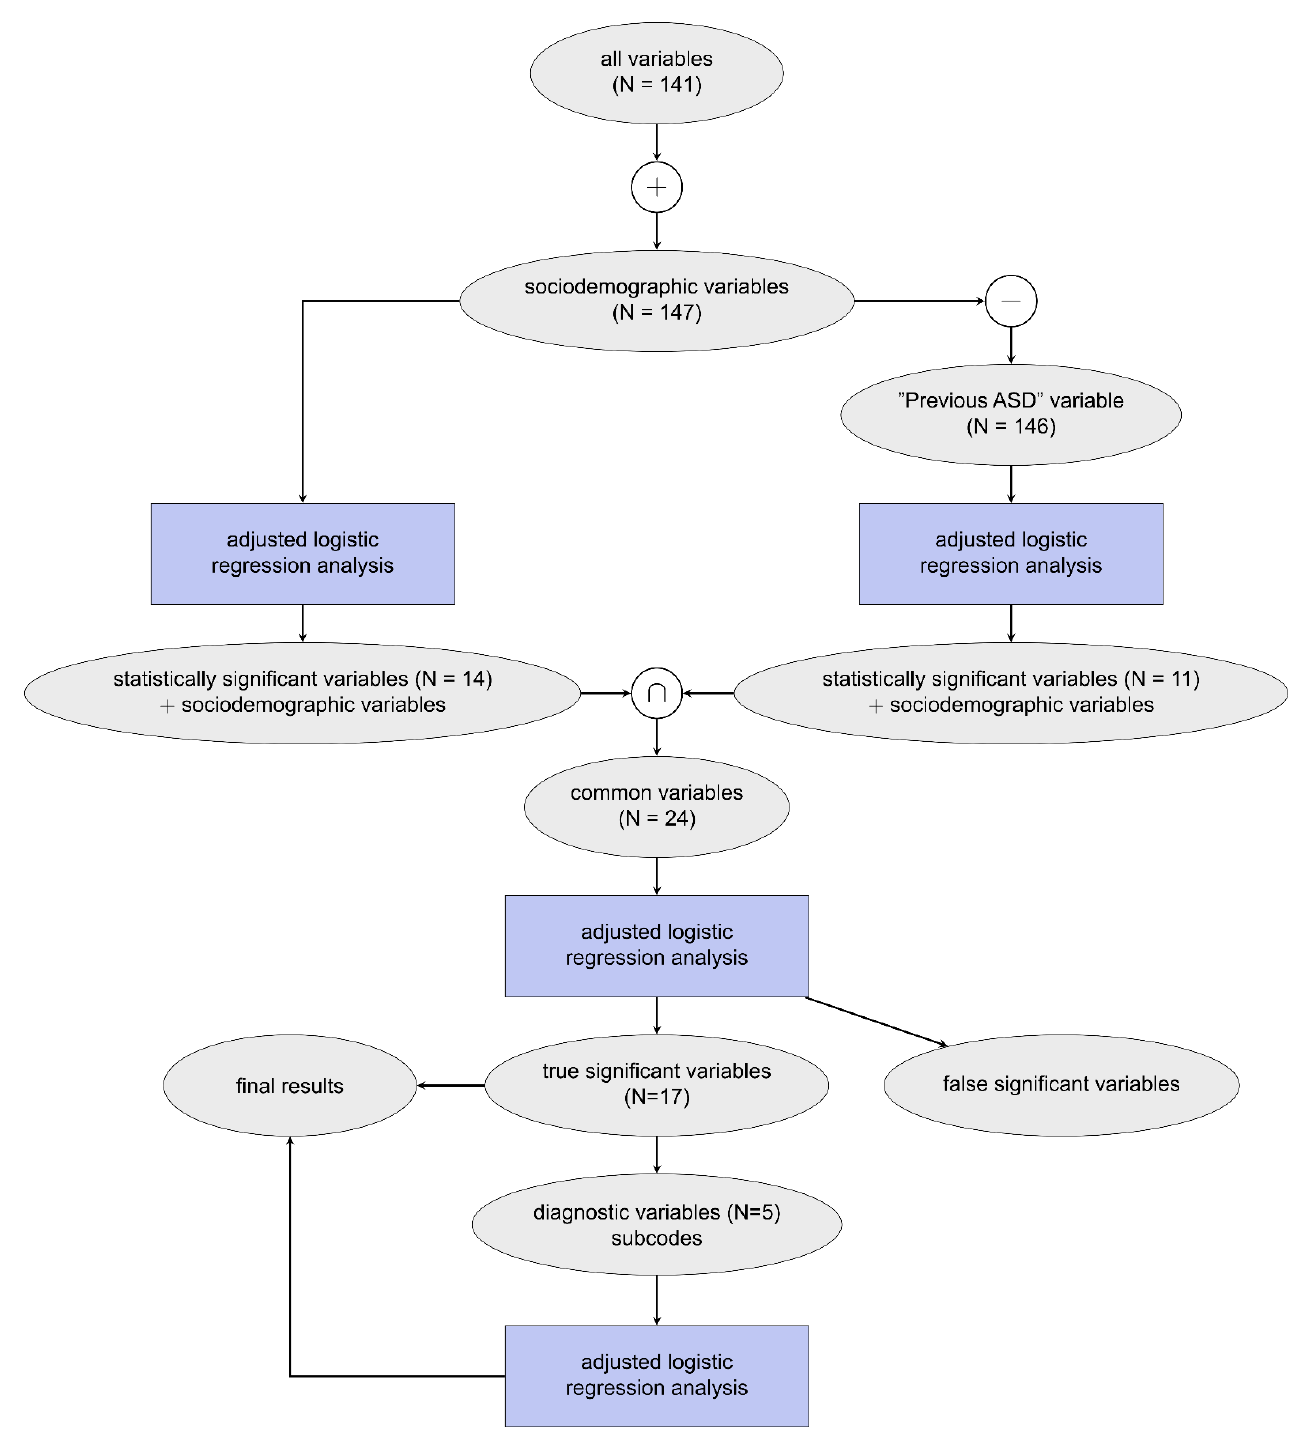
Figure 1. Schematic of model development where N represents the number of variables included for each analysis on claims data obtained throughout the entire pregnancy. This procedure was also repeated for each trimester individually (not shown).